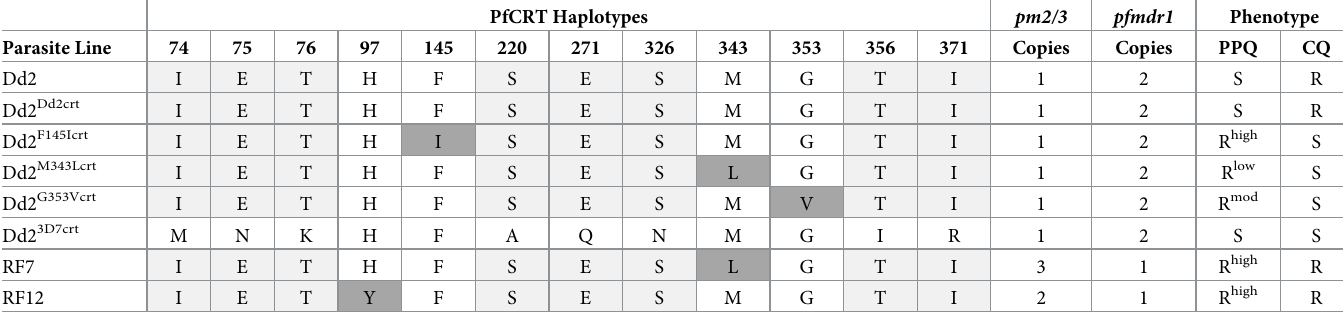
Table 1. PfCRT haplotypes and PPQ and CQ phenotypes of lines used